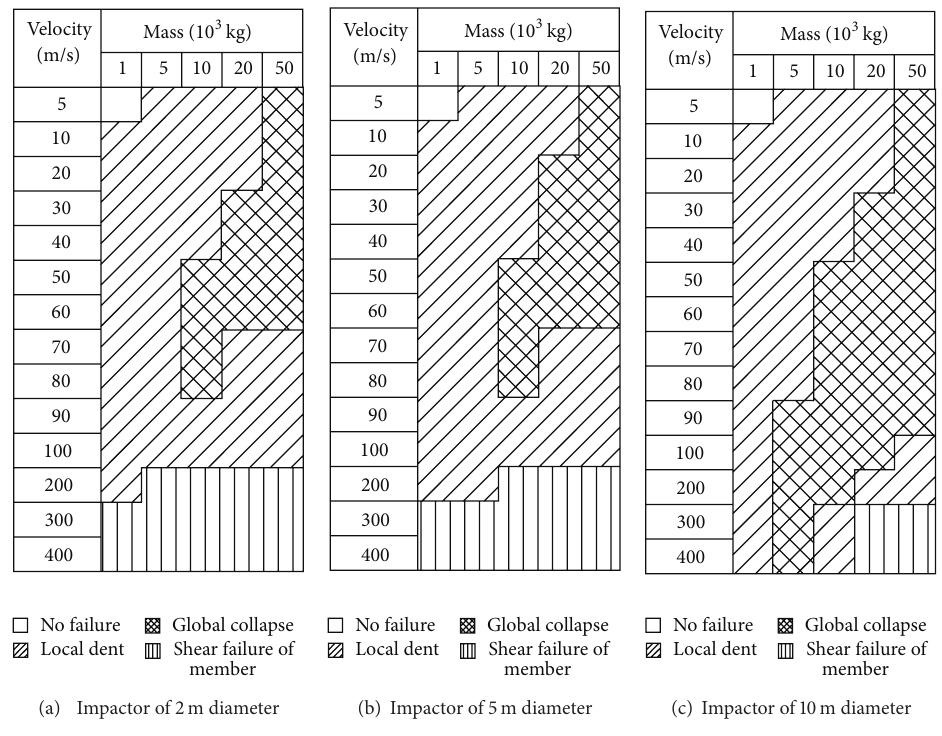
Figure 5: Damage modes of the impact events with the roof load of 60kg/m 2 .